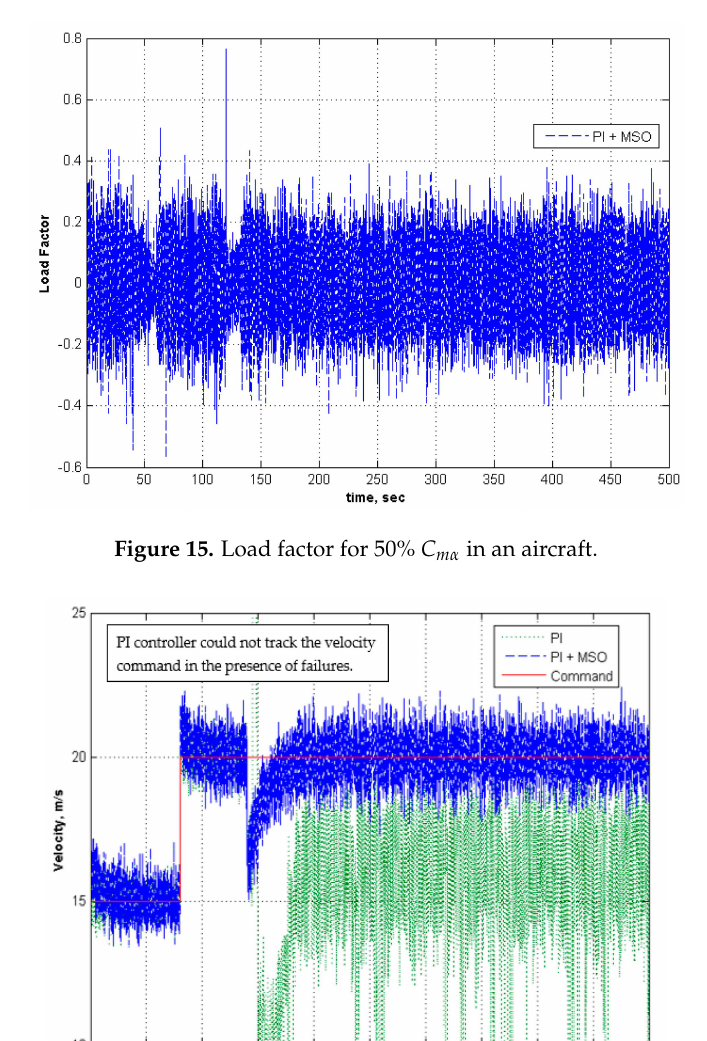
Figure 14. Elevator deflection for 50% C m α in an aircraft.